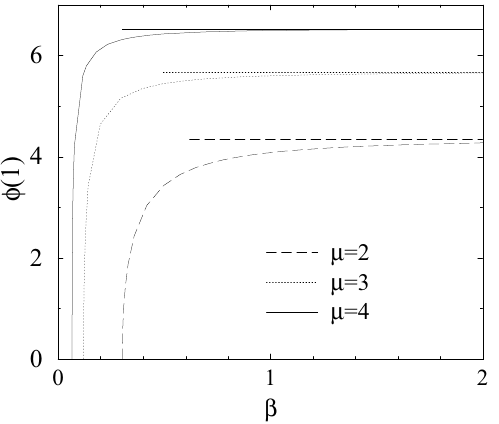
Fig. 2 – Surface potential of an anti-symmetric solution φ( 1 ) at ζ = 1 versus dimensionless parameter β . The dotted lines display an asymptotic value which can be computed ( Cf see Plouraboué and Chang (2009) for more details on this point). N ON - LINEAR PB P